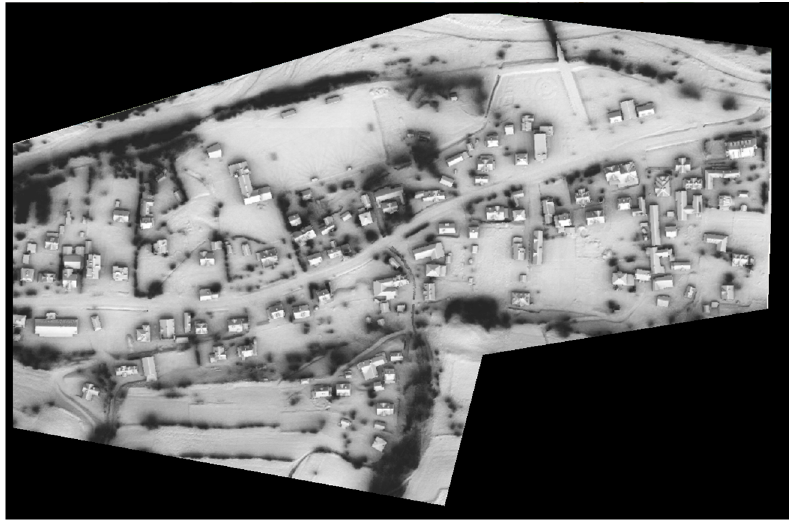
Figure 15. Digital height model for potential solar analyses.